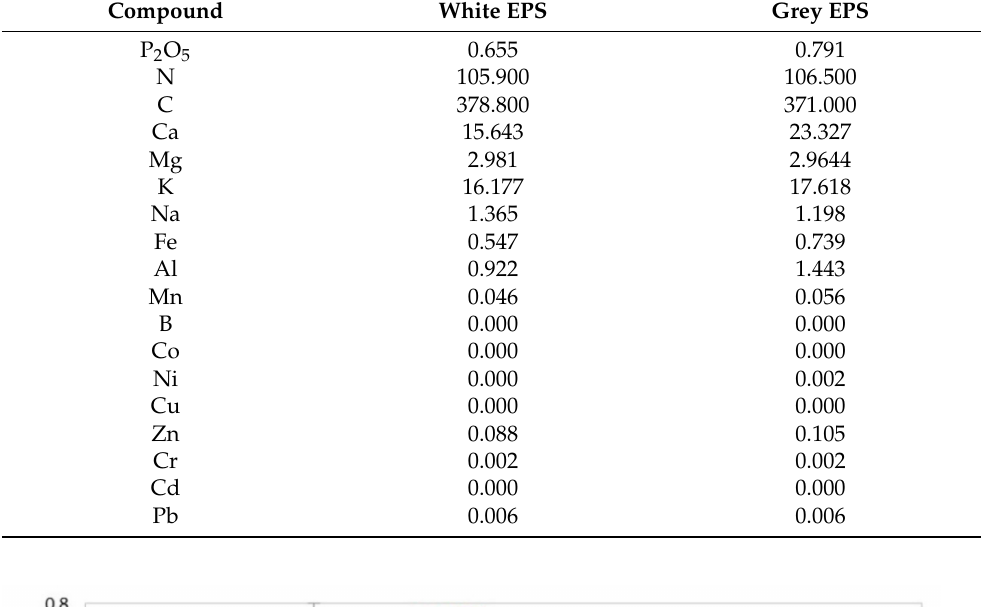
Table 3. Chemical composition of frass [g/kg].